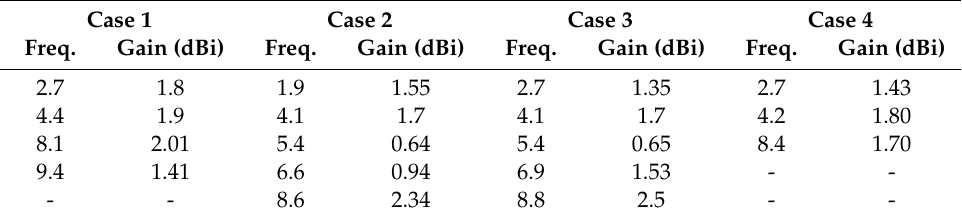
Figure 17. Radiation efficiency (%) of the proposed antenna in all cases. Table 7. Gain (dBi) in all four cases at resonance